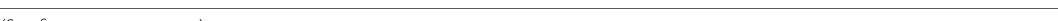
figure on next Fig. 8 Analysis of immune cell populations in tumor and secondary lymphoid organs from treated MC38 tumor-bearing mice. The experimental design is depicted chronologically. Mice were inoculated with MC38 tumors ( n 5 mice per group) at day 0. Eight days post-inoculation, the = tumors had been well established, and the mice were injected with different treatments as described in the methods section. Two days after the treatments, mice were sacrificed and organs were collected, processed, and stained for further analysis of the immune cell populations by means of flow cytometry. Gating was performed by FlowJo and included only live CD45.2 + cells. Populations were further gated to include helper T cells (CD3 + CD4 + ), CTLs (CD3 + CD8 + ), neutrophils (CD11b + Ly6G + ), DCs (CD11b + CD11c + ), and macrophages (CD11b + F4/80 + ). Cell populations in the tumor and dLNs are shown in ( a ) and ( b ), respectively. (Statistical differences are denoted as ns: not significant, * p < 0.05, ** p < 0.01, *** p < 0.001 and **** p < 0.0001). ( c ) Rational design of our current working network: P407 hydrogel-based synergistic PDT-immunotherapy for imaging and